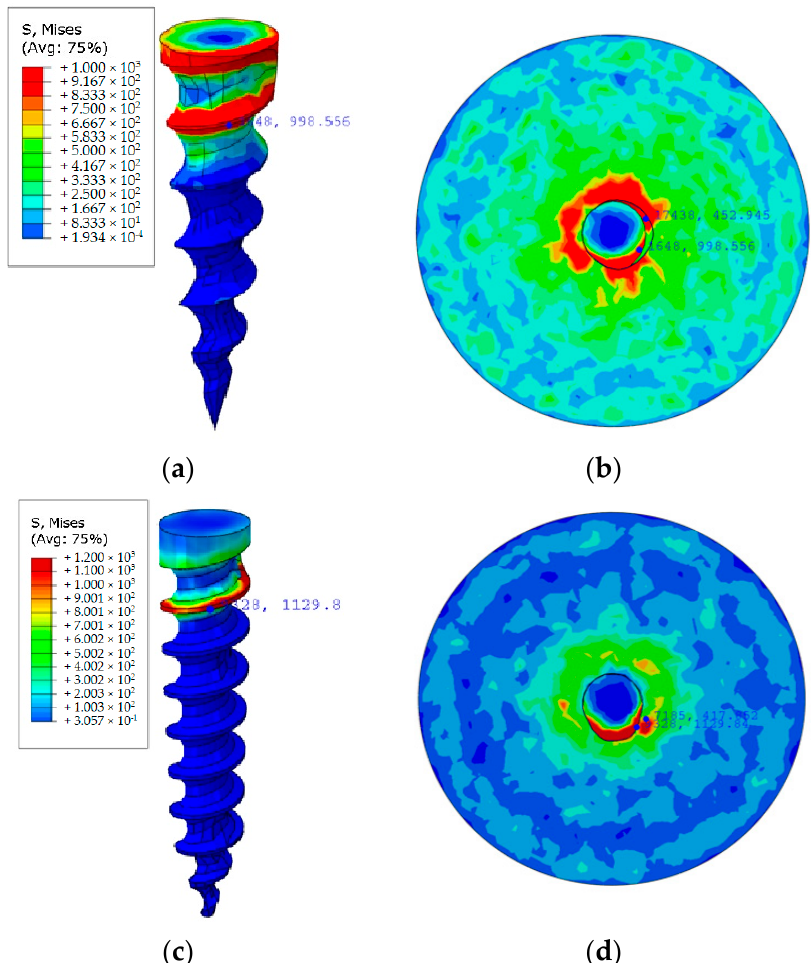
Figure 8. Von Mises stress generated on the mini-implant thread coil ( a and c ) and cross-section of the most stressed implant zone with effects on the surrounding cortical bone ( b and d ); ( a and b ): Tomas®-pin and ( c and d ): Perfect Anchor).